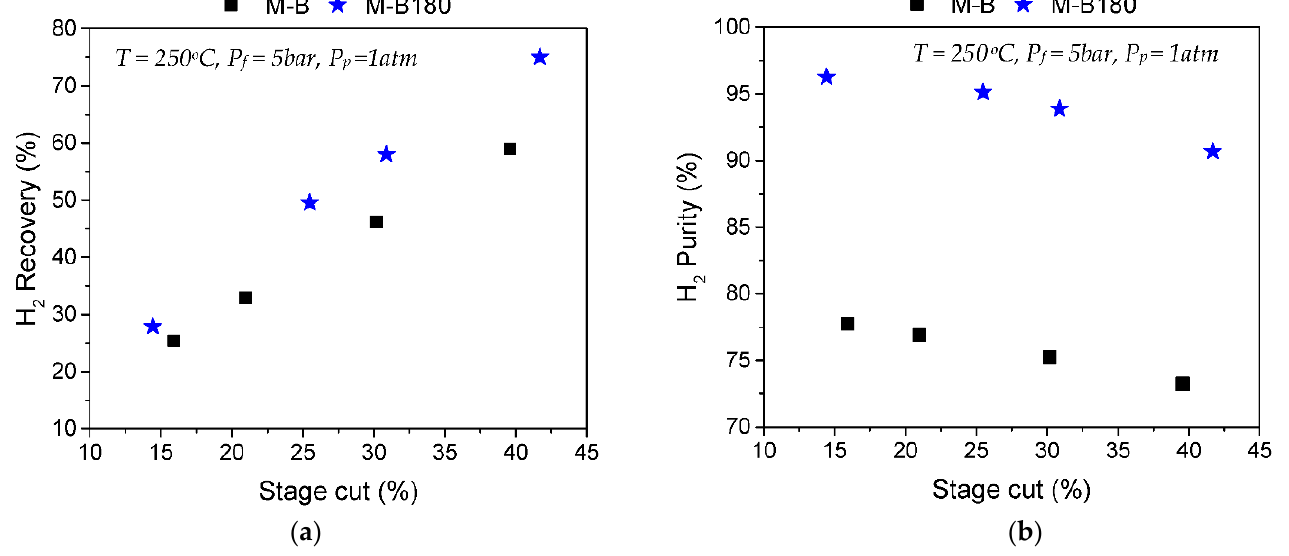
Figure 6. Results of H 2 /CH 4 (50/50) separation tests at 250 °C, P f = 5 bar and P p ambient. Comparison of ( a ) H 2 recovery% as a factor of stage cut% and ( b ) H 2 purity% as a factor of stage cut% between membranes M-B and M-B180.